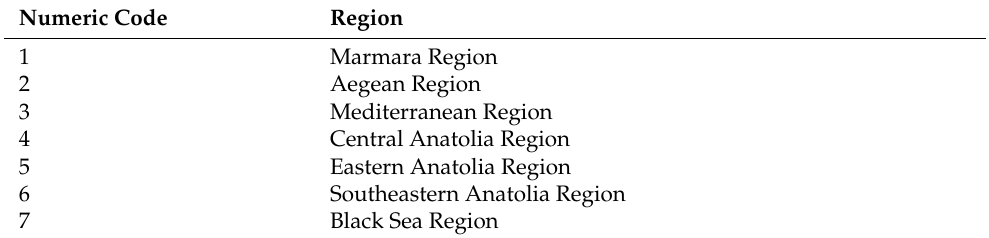
Table 1. Region names and corresponding numeric codes.